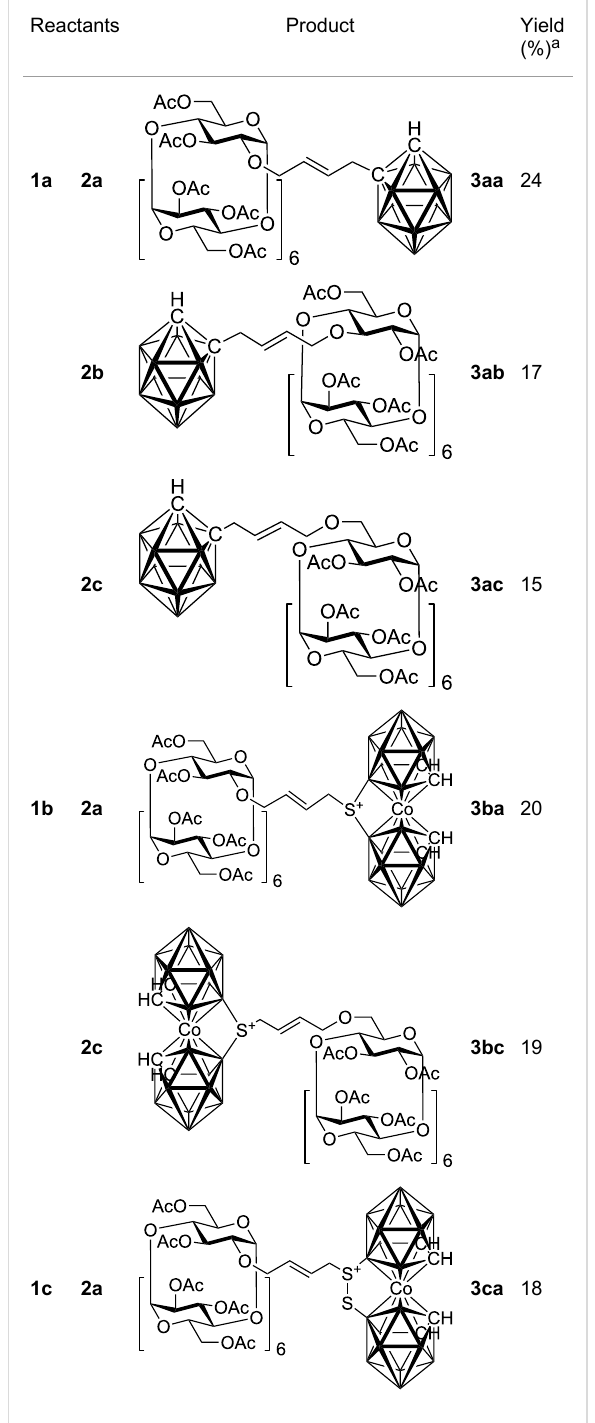
Table 1: The prepared carborane-cyclodextrin conjugates 3 .